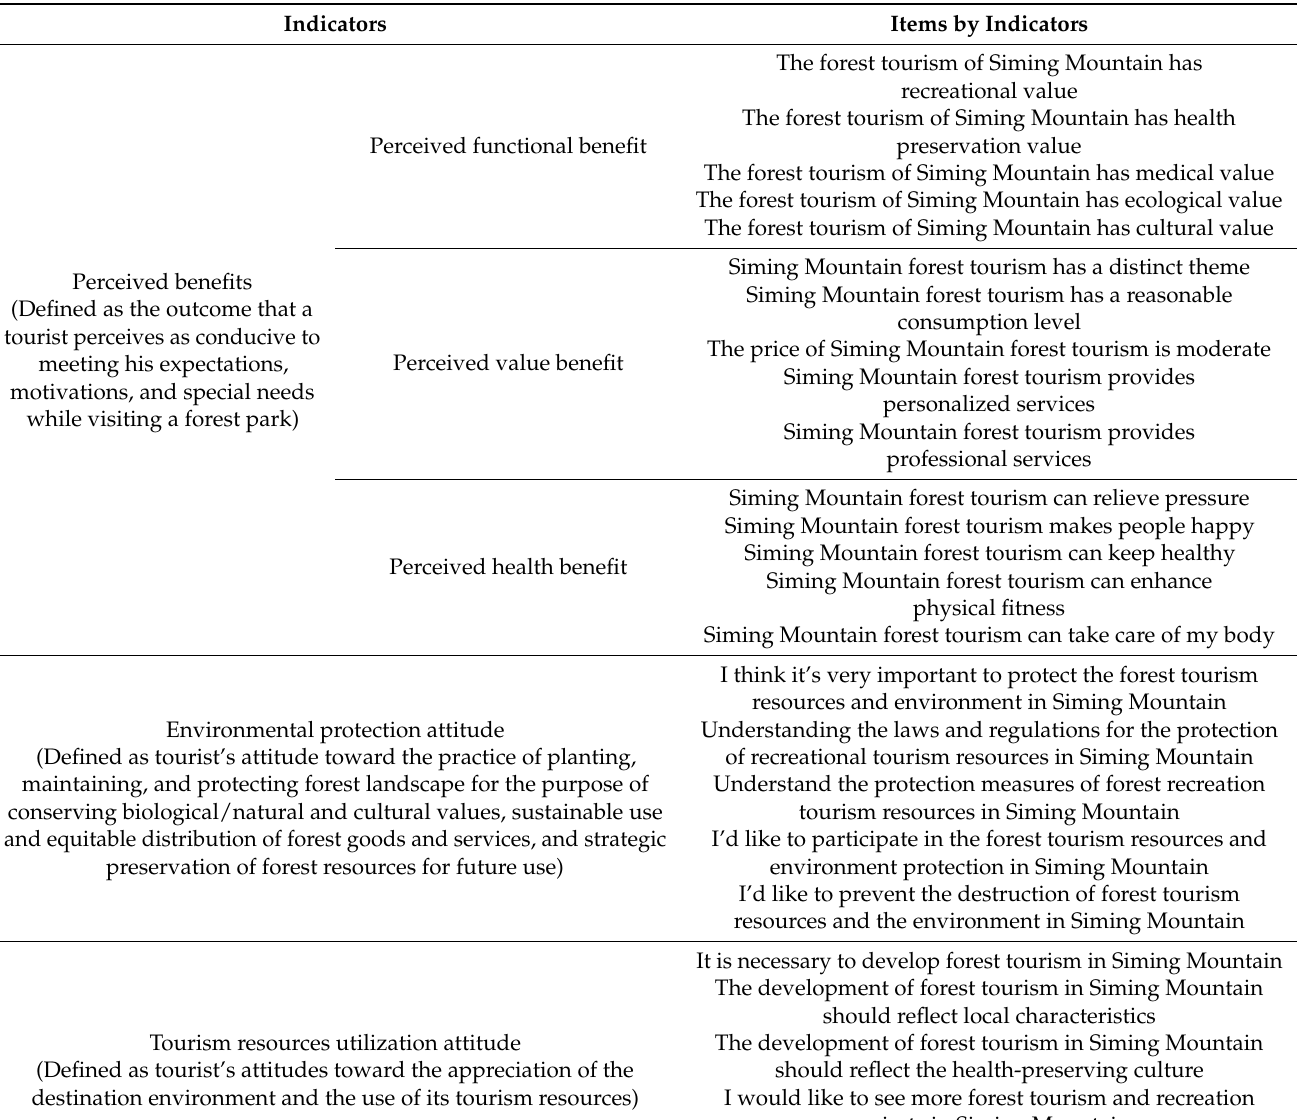
Table A1. The questionnaire was designed and used in this